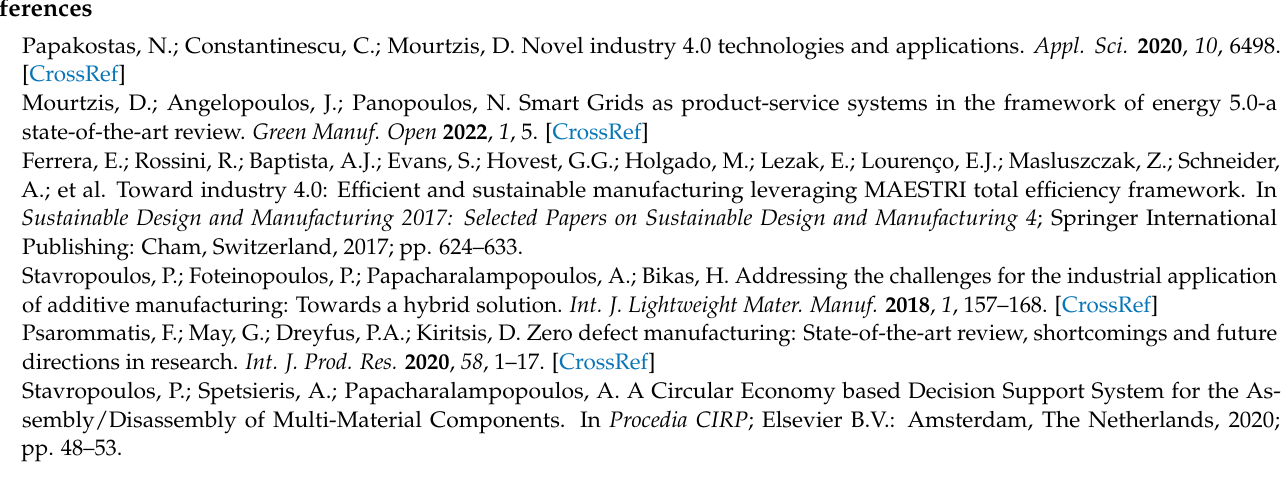
Figure A11. Technologies’ classification: Policies-related branch.